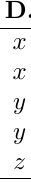
Table 4: 2-axis trunnion: load positions relative to cen- tre of table surface (see fig. 10). Coordinates